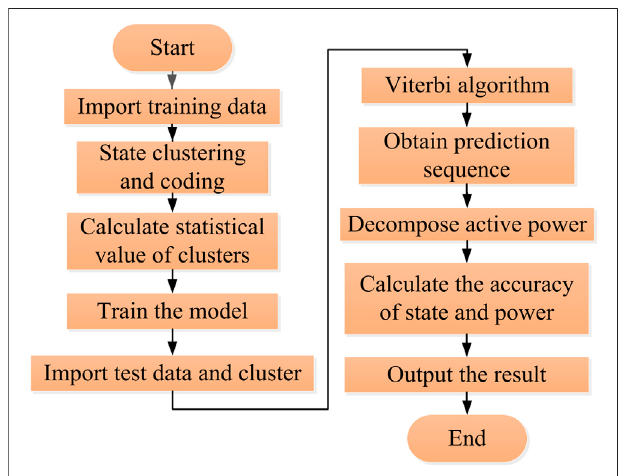
FIGURE 3 | Flow chart of NIPLI based on